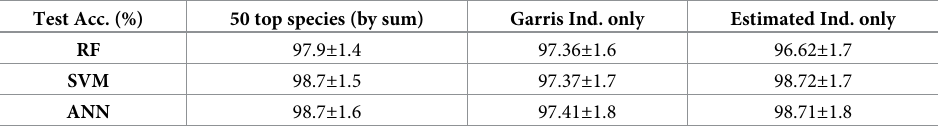
Table 7. Testing-set accuracy comparison between classifiers, using either all species or only indicator species as inputs. Plus-minus value represents one standard deviation. Test Acc.